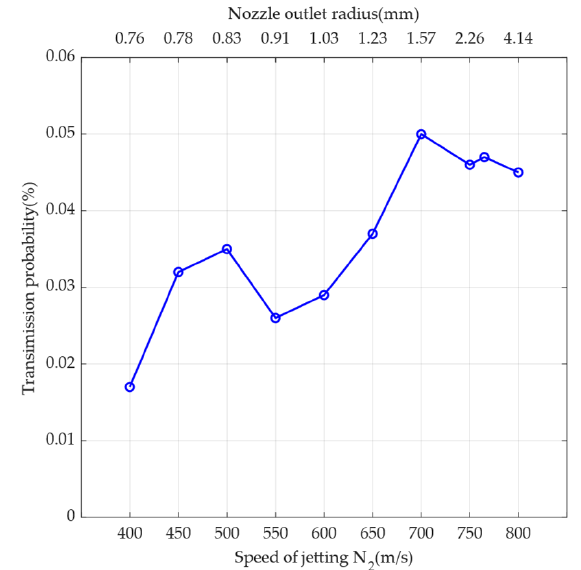
Figure 9. Relationship between the speed of jetting N 2 and transmission probability. The simulation results are indicated by circles in the line graph. The primary x-axis at the bottom indicates the speed of jetting N 2 , and the secondary x-axis at the top indicates the nozzle outlet radius at the corresponding speed. The y-axis indicates the transmission probability, which is the ratio of the number of particles received at the sensor sampling port to the total number of particles.